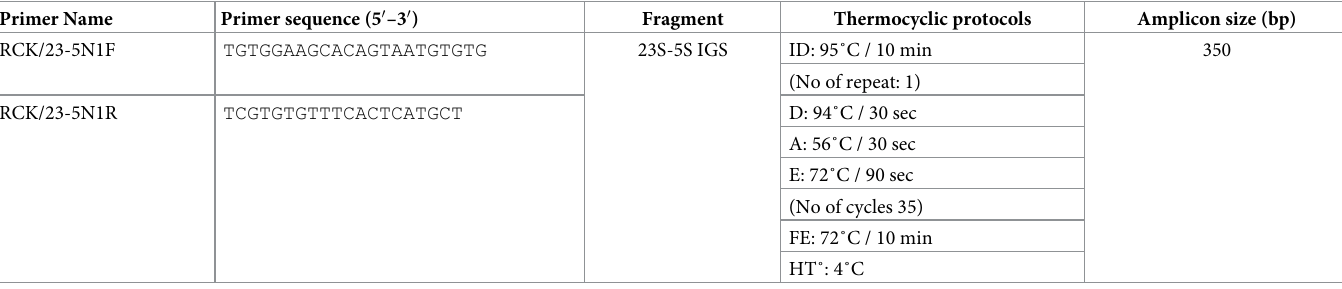
Table 1. Rickettsia massiliae oligonucleotide primers used for PCR amplification and its thermocyclic protocols. Primer